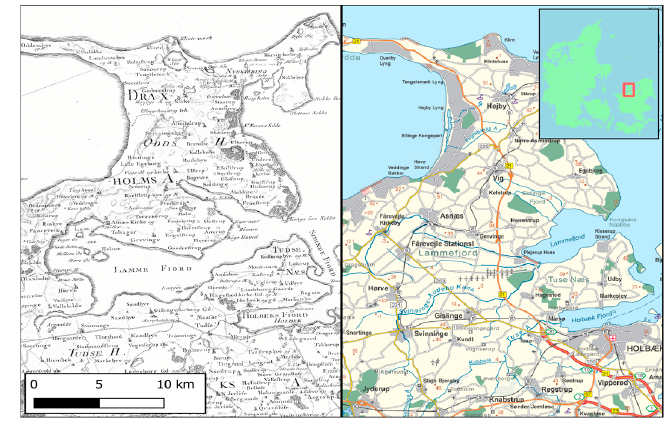
Figure 5. Comparison between the Videnskabernes Selskabs map from 1770 ( left ) [44] and 1:200,000 present day mapping of the Lammefjord area from Kortforsyningen ( right ). Extensive land reclamation in the inner fjord occurred from the mid-19th Century CE. This is illustrative of the dramatic alteration of landscapes that occurred across the country.